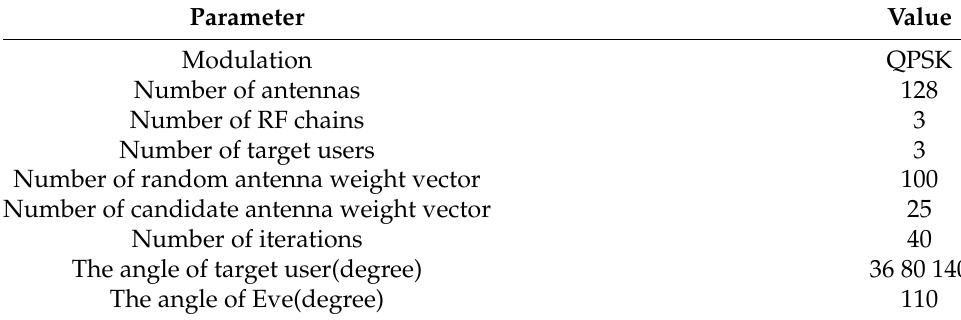
Table 4. Simulation parameter